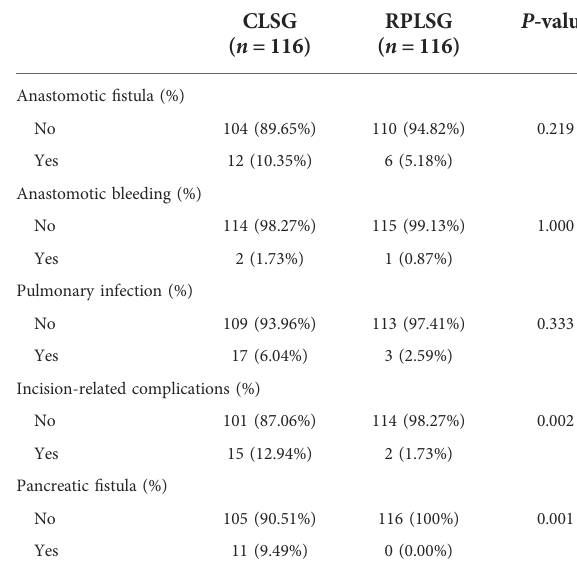
TABLE 6 Postoperative safety